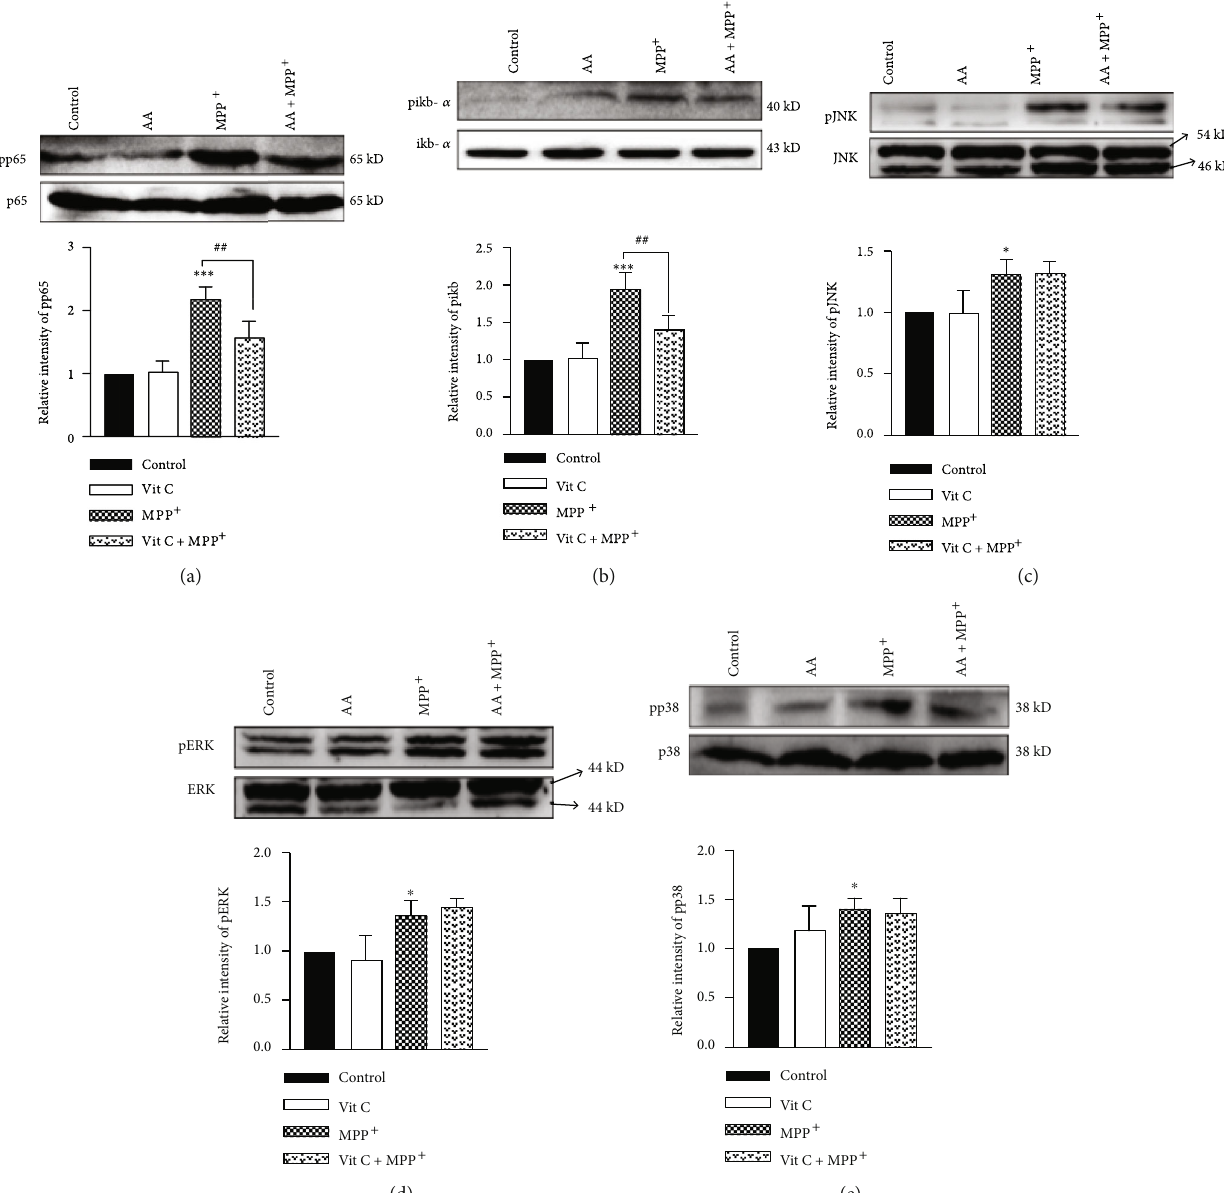
Figure 3: Ascorbic acid inhibits MPP + -induced nuclear factor-kappaB (NF- κ B) activation but does not a ff ect p38/ERK or JNK signaling in astrocytes in vitro . Primary cells were treated with 1 mM of AA for 24h and/or 1 mM of MPP + for another 24 h. (a) The expression of phosphorylated p65 (pp65) was detected by Western blotting ( n = 3 ). (b) The expression of phosphorylated i κ B α (pi κ B α ) was detected by Western blotting ( n = 3 ). (c) The expression of phosphorylated JNK (pJNK) was detected by Western blotting ( n = 3 ). (d) The expression of phosphorylated ERK (pERK) was detected by Western blotting ( n = 3 ). (e) The expression of phosphorylated p38 (pp38) was detected by Western blotting ( n = 3 ). Data were obtained from three independent experiments. One-way ANOVAs followed by LSD pairwise comparisons were performed. ∗ was considered signi fi cant compared to control ( ∗ P < 0 : 05 , ∗∗ P < 0 : 01 , and ∗∗∗ P < 0 : 001 ). # was considered signi fi cant compared to MPTP or MPP + ( # P < 0 : 05 , ## P < 0 : 01 , and ### P < 0 : 001 κ B signaling occluded the protective e ff ects of AA in MPP + - treated astrocytes through suppressing the expression of antioxidative proteins.